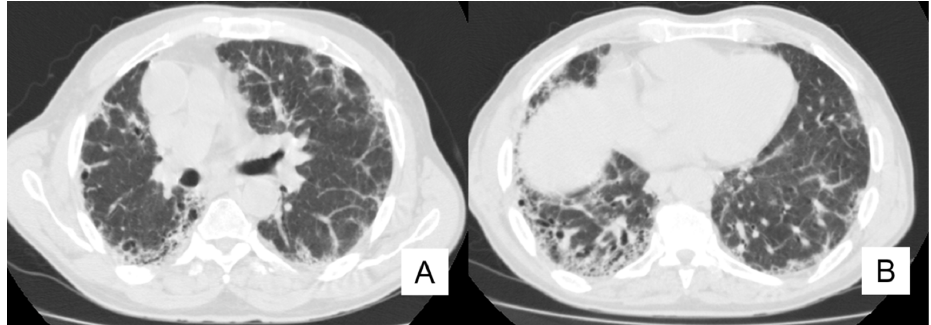
Figure 13. An 80-year-old man with values of SpO 2 , Forced Vital Capacity (FVC) and Forced Expiratory Volume in one second (FEV1) equal to 94%, 57% and 56%, respectively (at first CT scan). A typical IPF pattern was clearly depicted ( A , B